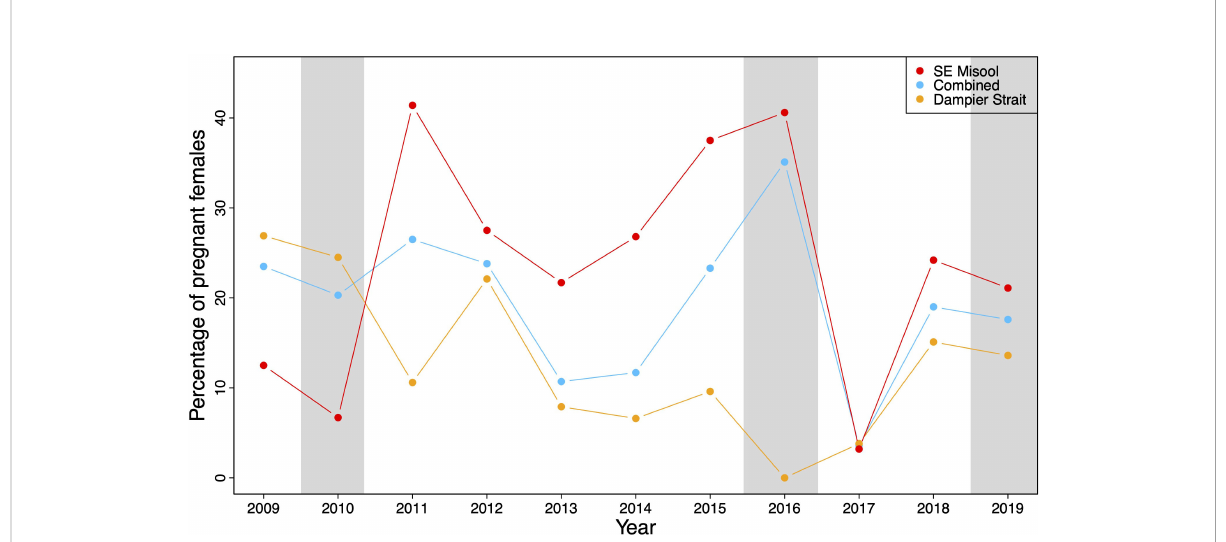
FIGURE 2 The percentage of pregnant M. alfredi relative to the total number of females in South East (SE) Misool (in red), Dampier Strait (in orange), and both MPAs (in blue) combined in 2009 – 2019. Grey shading represents three different El Niño events based on